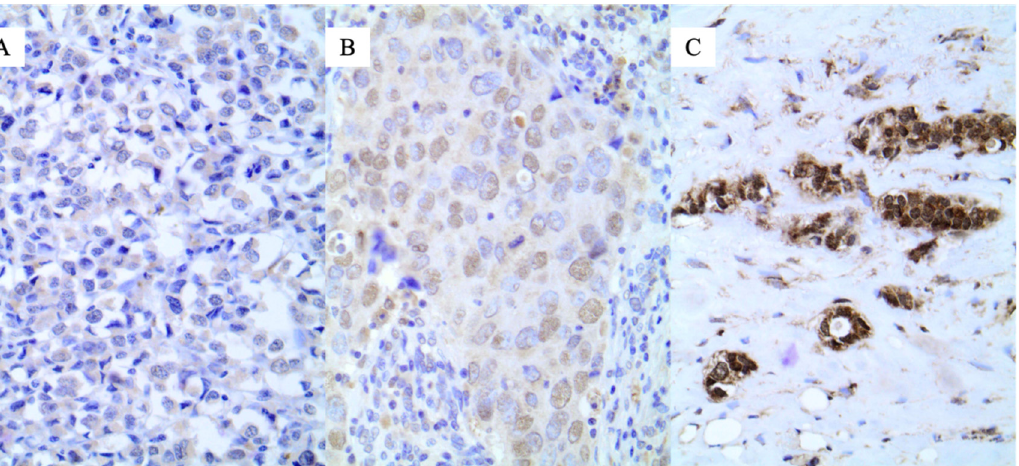
Figure 2. HDAC-2 immunohistochemical expression in breast cancer tissue (×400). ( A ): Negative nuclear staining. ( B ): Mild to moderate nuclear staining. ( C ): Strong nuclear staining.